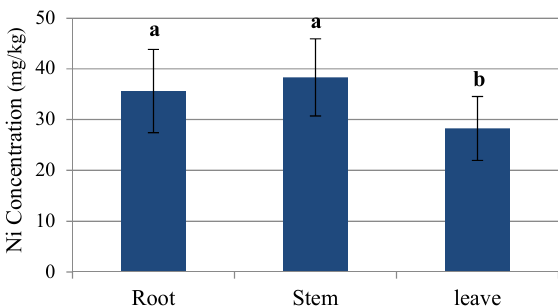
Fig. 3. Mean Ni Concentration in Treatment of 50 mg/kg